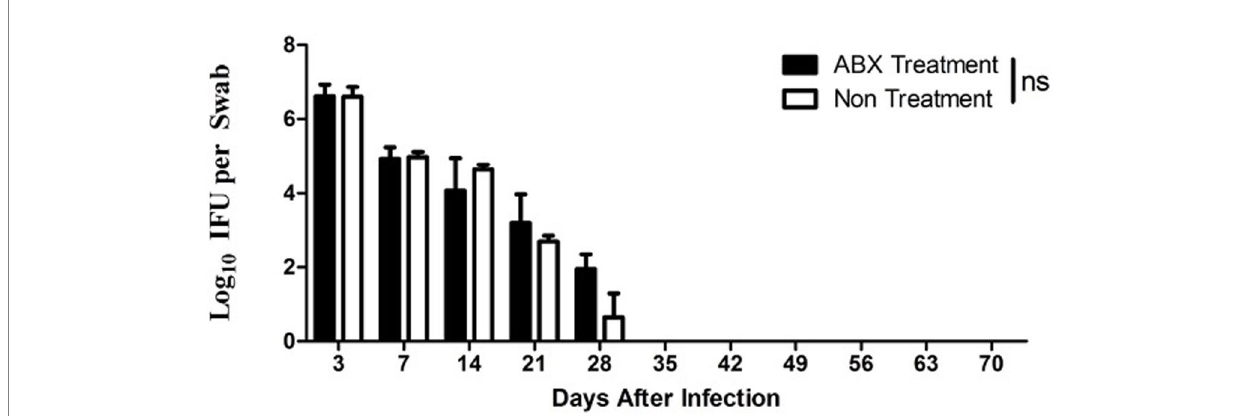
FIGURE 2 Oral ABX treatment did not alter chlamydial infection in the genital tract. Female DBA2/J mice without (Non, n = 20) or with (ABX, n = 20), oral antibiotics treatment for 21 days was intravaginally infected with C. muridarum as described in Figure 1 legend. Live organism shedding was monitored from vaginal swabs on days 3, 7 and weekly thereafter (up to day 70) as shown along X-axis. Both live organisms recovered (Log10 IFUs per swab) were shown along Y -axis. Note that significant shedding was similarly detected in all mice up to day 28 after infection regardless of the oral antibiotics’ treatment ( p > 0.05, Wilcoxon for comparing